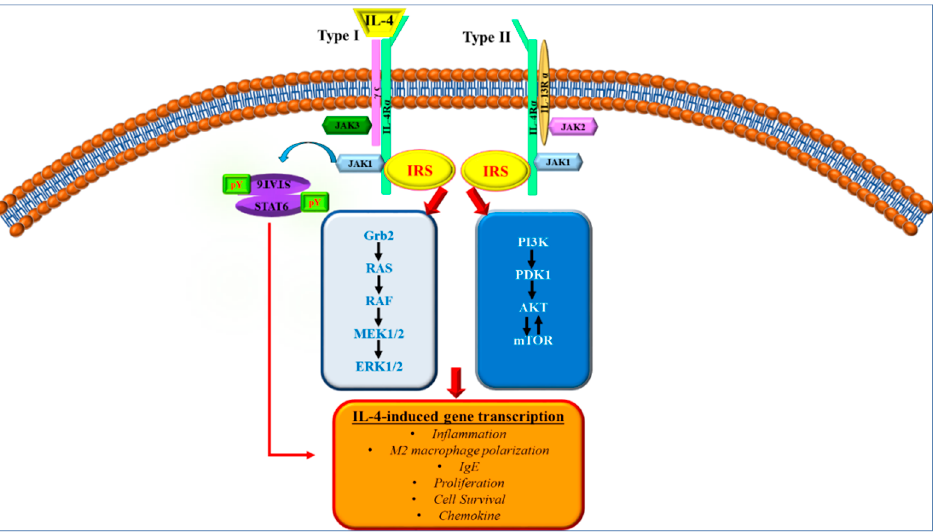
Figure 2. Interleukin-4-induced gene transcriptional effects through IRS and STAT6 acti- vations. Upon binding of IL-4, tyrosine phosphorylated IL receptors generate binding binding of IL-4, tyrosine phosphorylated IL receptors generate binding sites for JAK1/2 and sites for JAK1/2 and IRS proteins. JAK1/2 are mainly responsible for the activations of IRSs and STAT6 that trigger the IL4 -induced cellular effects such as inflammation, cell sur- vival, and proliferation (adapted from [61]).